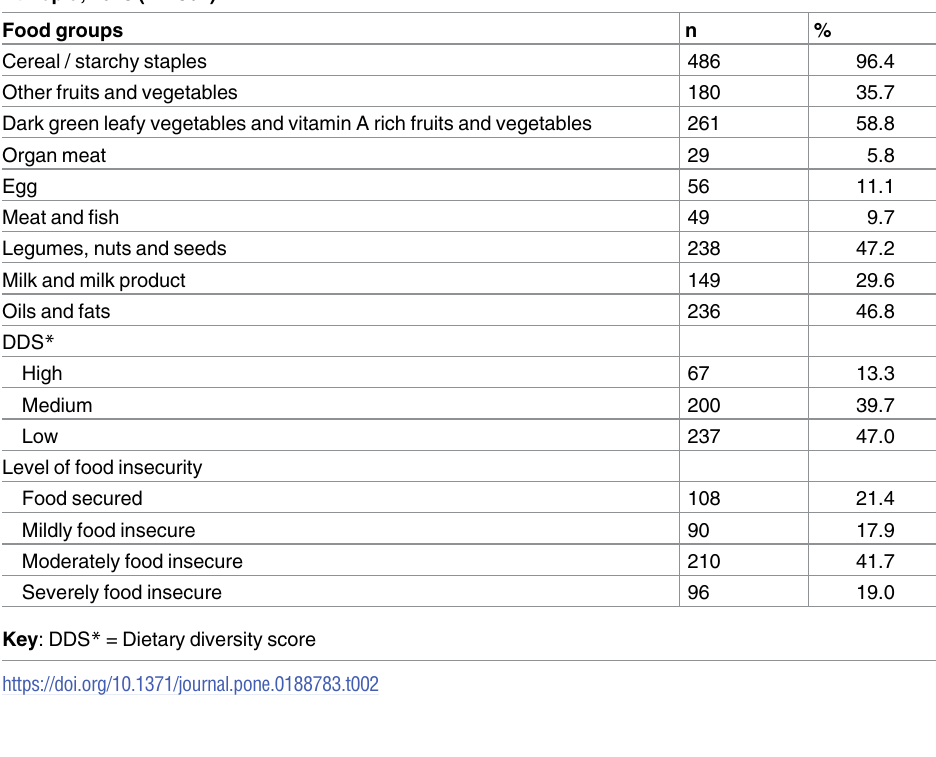
Table 2. Dietarypracticeand level of food securityamong pregnant women in Lemo district, Southern Ethiopia, 2015 (n = 504).